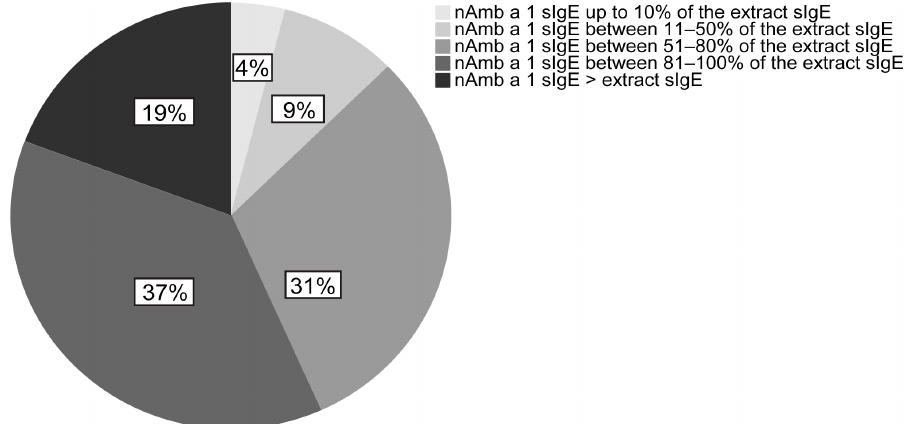
Figure 2. The percentage of patients showing different nAmb a 1 sIgE levels corresponding to ragweed extract IgE levels in 150 patients. nAmb a 1 sIgE value (kUA/L) was divided to extract sIgE to obtain the percentage for each patient. Based on the results obtained, patients were divided in 5 groups: nAmb a 1 sIgE made up to 10% of the extract sIgE, nAmb a 1 between 11 and 50%, nAmb a 1 between 51 and 80%, nAmb a 1 between 81 and 100%, and nAmb a 1 higher than extract.